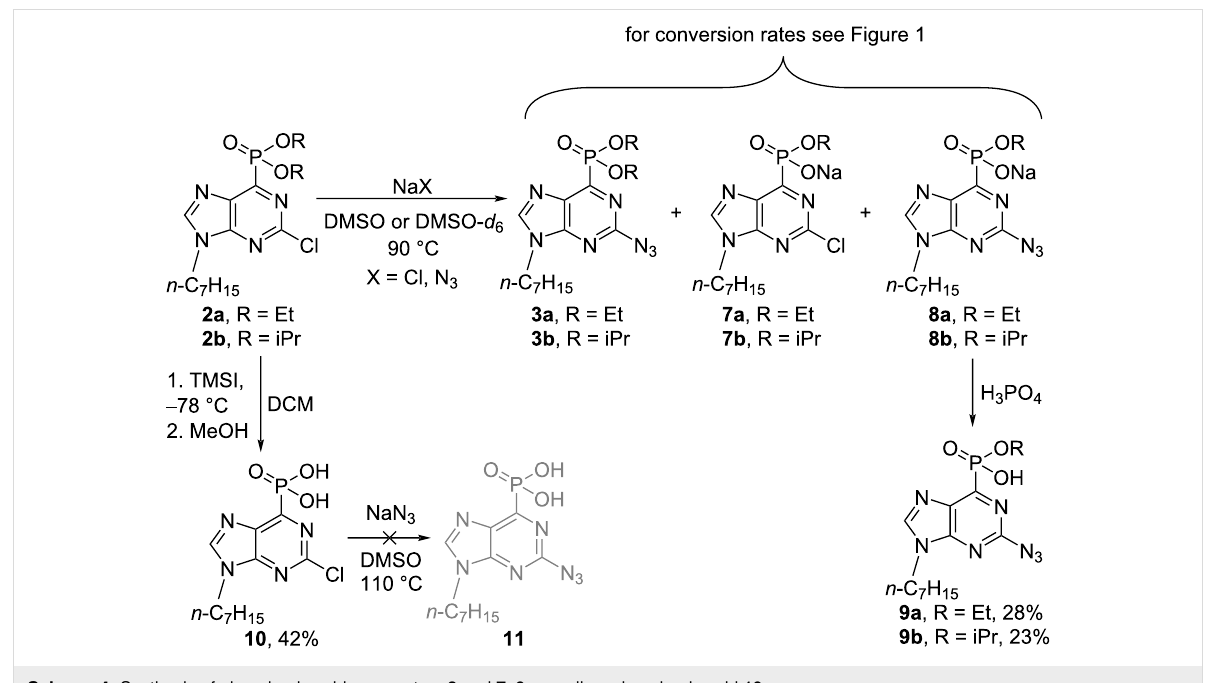
pure azido-substituted phosphonate monoesters 9a and 9b in 28 and 23% yield, respectively (Scheme 4). The products 9a and 9b were further submitted to CuAAC reactions, but the desired triazole derivatives were not obtained. Further-